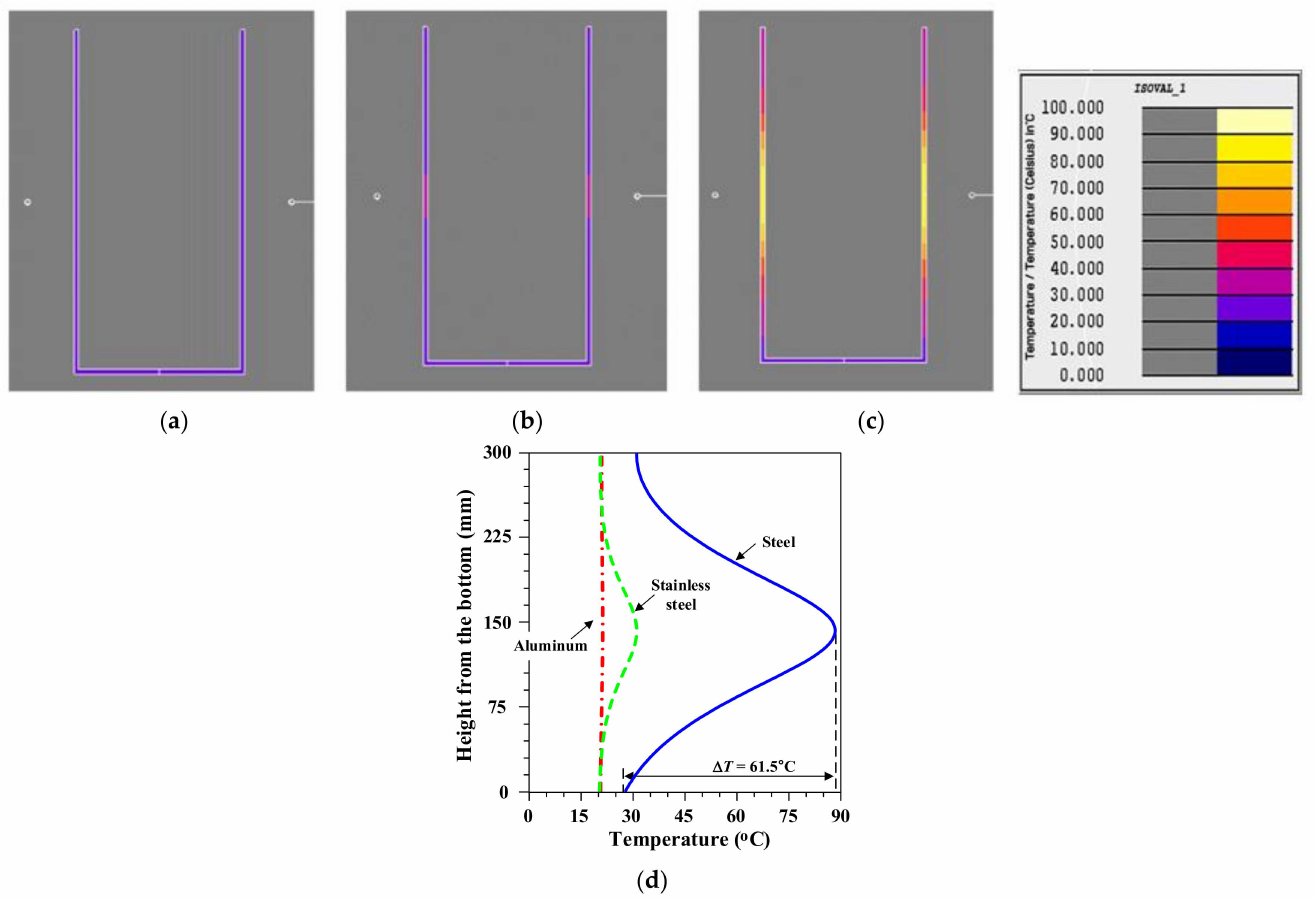
Figure 3. Temperature distribution for different formwork materials: temperature contour of forms made with ( a ) aluminum, ( b ) stainless steel, and ( c ) steel; ( d ) temperature distribution